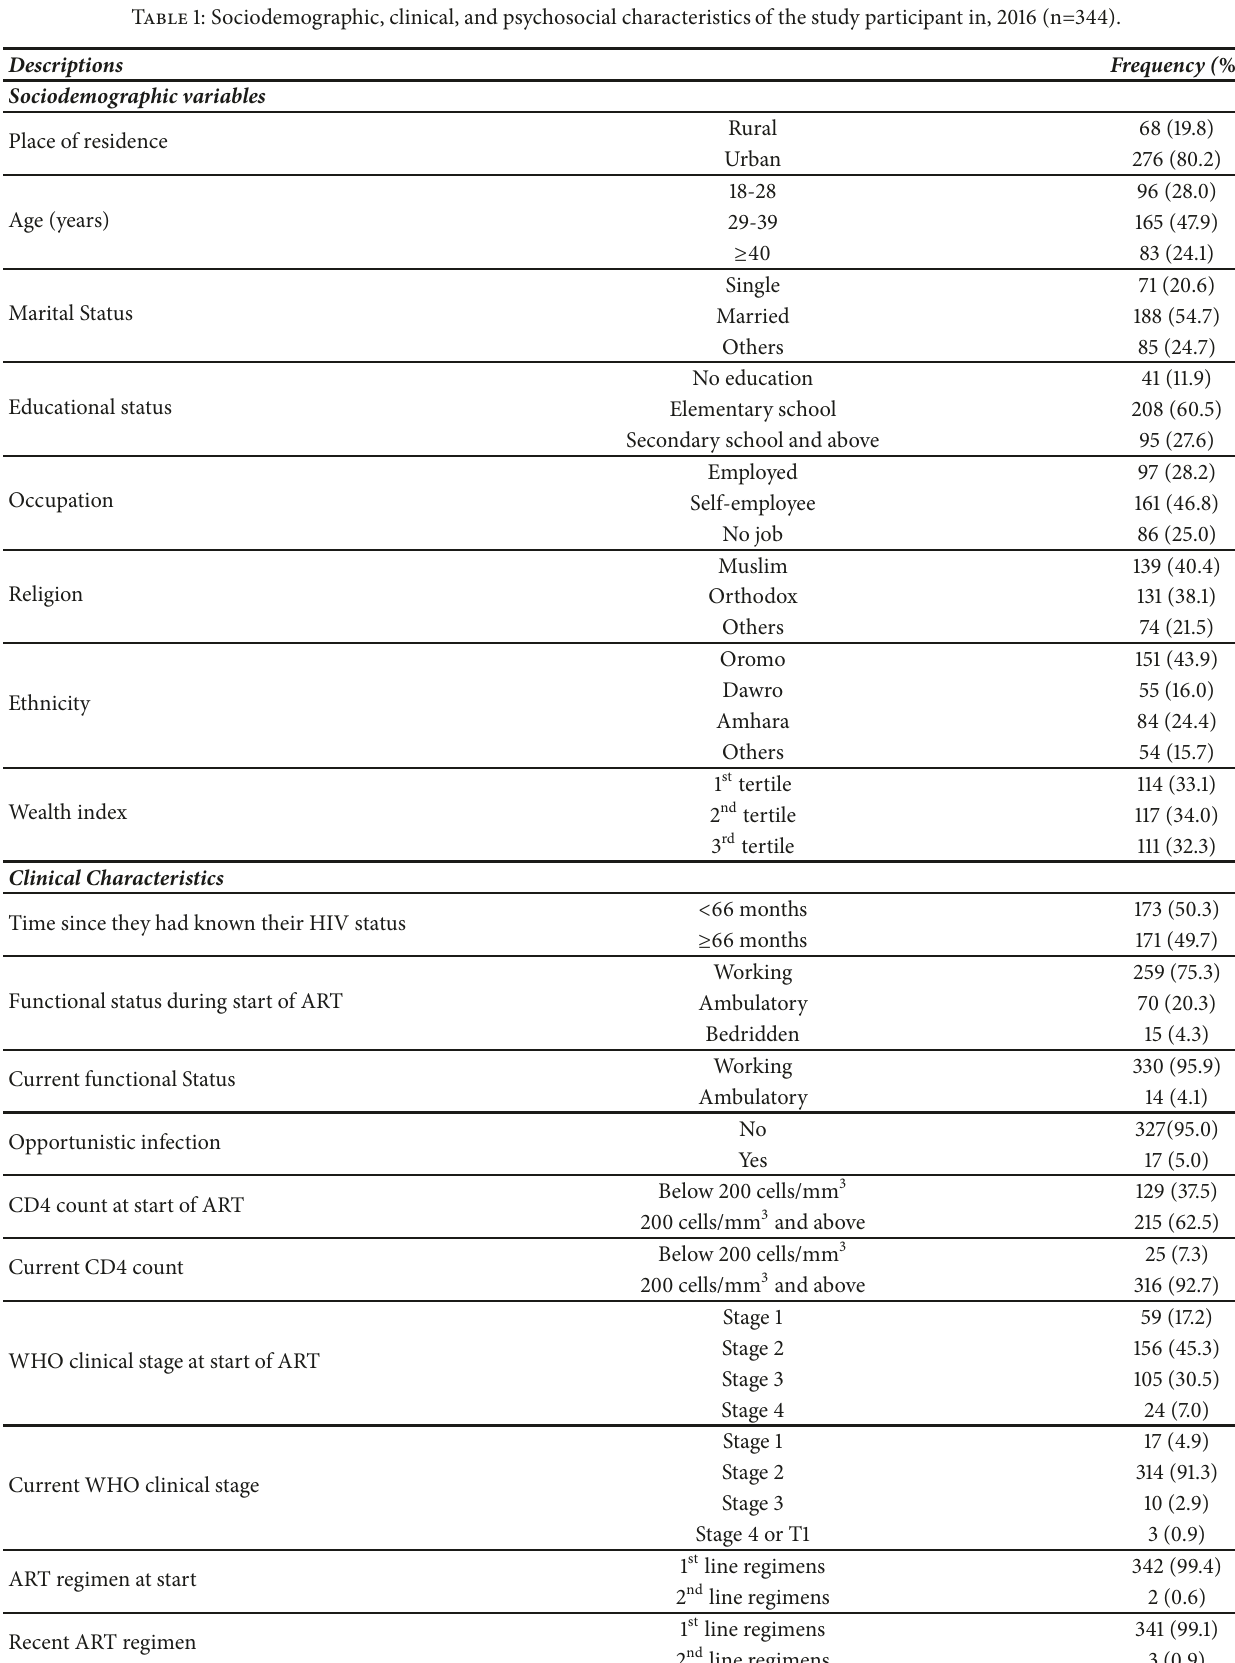
Table 1: Sociodemographic, clinical, and psychosocial characteristics of the study participant in, 2016